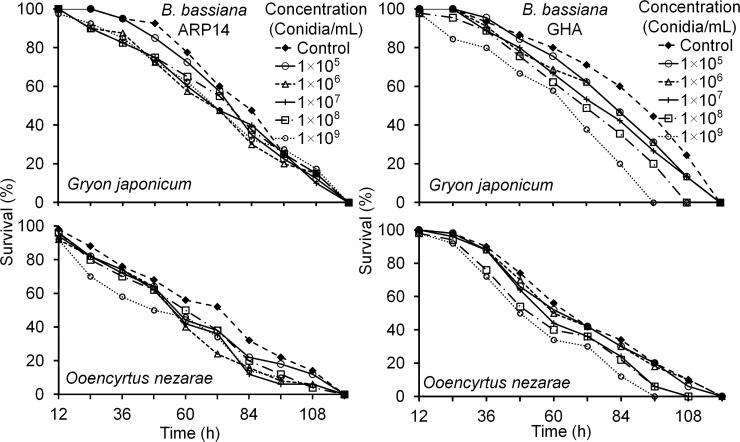
Survivorship of different egg parasitoids of Riptortus pedestris exposed to different concentrations of Beauveria bassiana of the ARP14 or GHA strains.